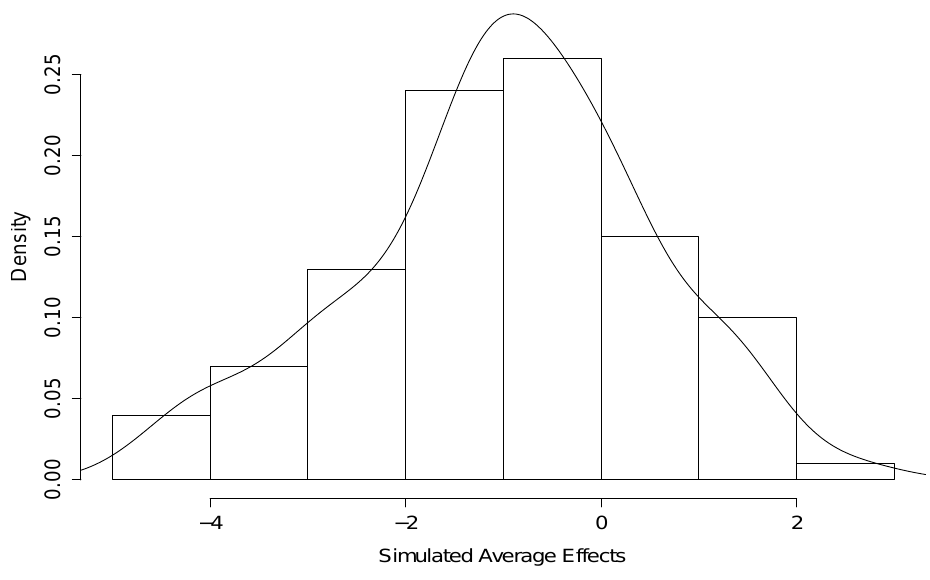
Figure 3: Histogram and kernel density estimate of the simulated SATE distribution for the fitted Clayton180 copula model.